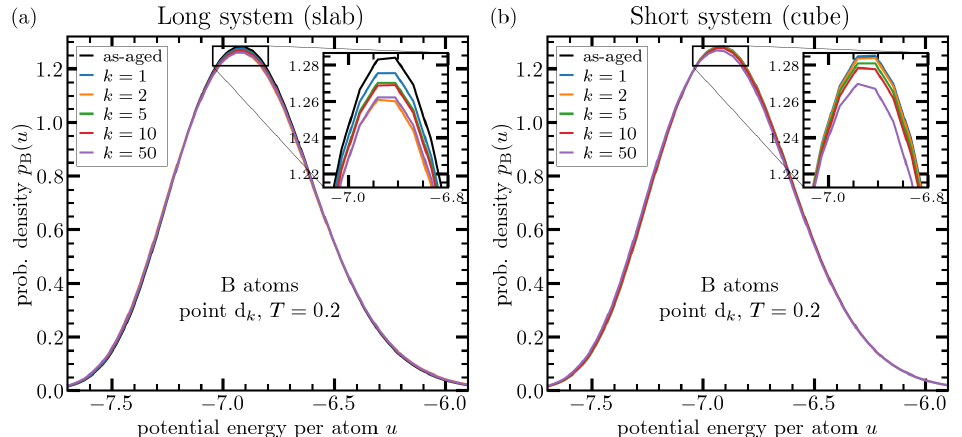
Figure 5. The same data as in Figure 4 for B-type particles. Panel ( a ) shows data for a system with a linear dimension of L slab = 2000 particle diameters (slab geometry), panel ( b ) depicts similar data for a cubic system with L cube = 128. Different curves correspond to different number of thermal cycles as indicated in the legends. In the case of B-particles, it is still more difficult to make a judgment based on the overall shape of the distribution.